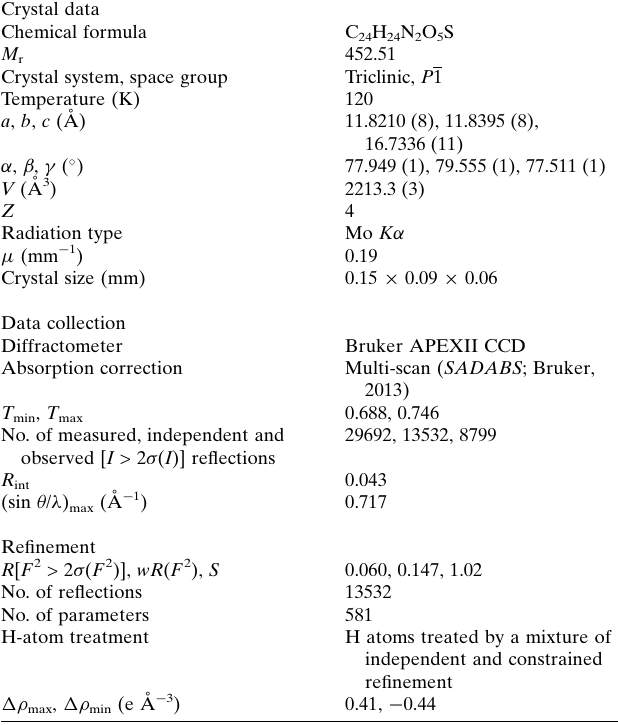
Table 4 Experimental details. Crystal data Chemical